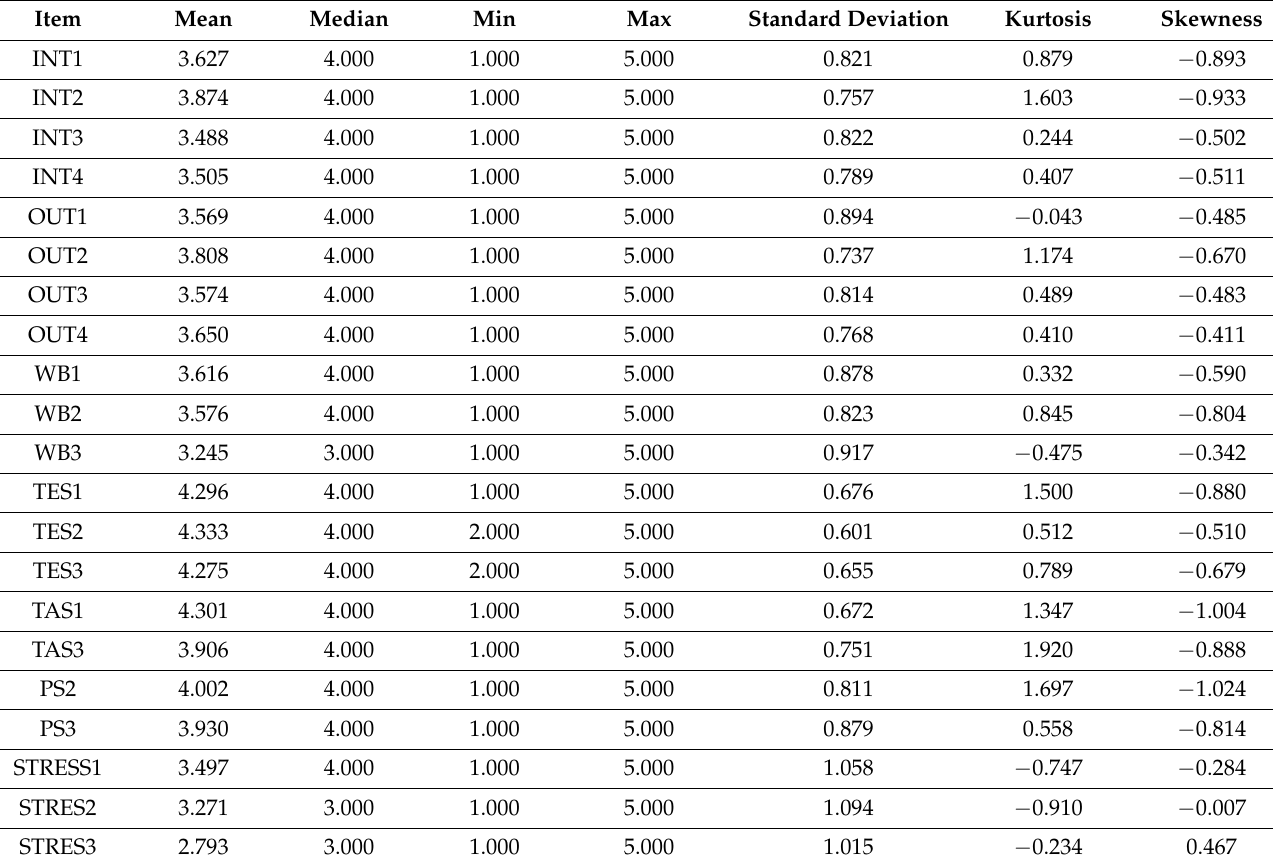
Table 2. Descriptive statistics in